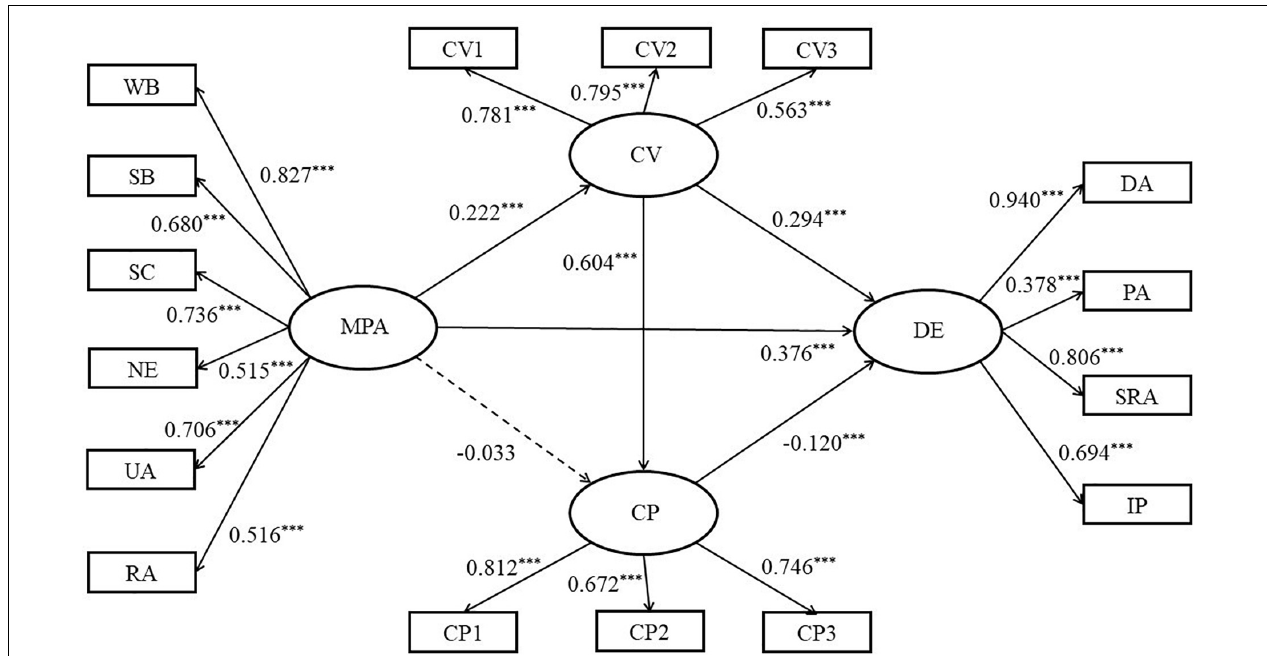
FIGURE 2 | Multiple mediation model. Path values are the path coefficients (standard errors). ∗∗∗ Correlation is significant at the 0.001 level (2-tailed), MPA, mobile phone addiction, WB, withdrawal behavior, SB, salience behavior; SC, social comfort; NE, negative effects; UA, use of application (App); RA, renewal of app; CV, cyberbullying victimization; CP, cyberbullying perpetration; CV1–CV3 and CP1–CP3 are packaged dimensions; DE, depression; DA, depressed affect, PA, positive affect; SRA, somatic and retarded activity; IP, interpersonal.